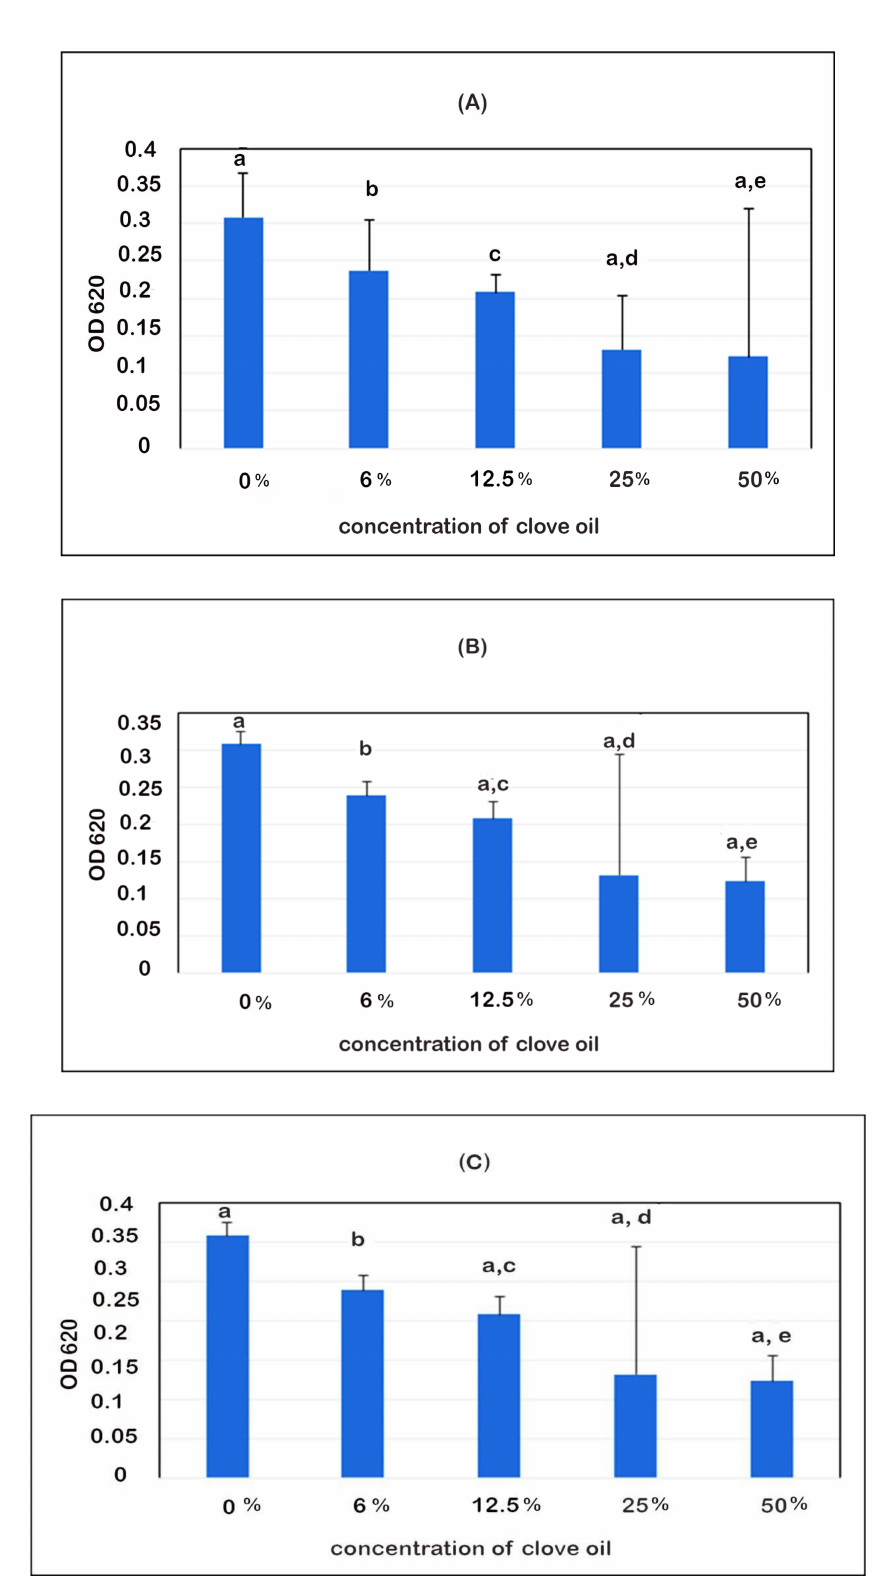
Figure 6. Quantitative analysis demonstrating how clove oils affect the growth of Pseudomonas spp. biofilms. Pseudomonas spp. biofilm development was measured in the presence of clove oil following 24 h culture in 96-well plates (620). ( A ) Clove oil’s antibiofilm properties against strong biofilms P. aeruginosa isolates; ( B , C ) clove oil’s antibiofilm properties against moderate biofilms P. aeruginosa